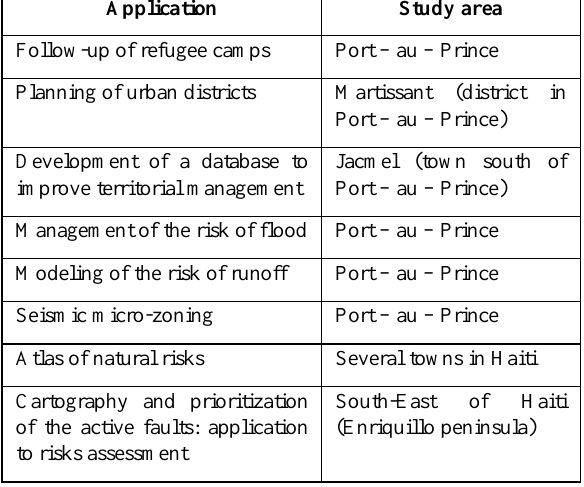
Table 1. Some of the applications of the KAL-Haiti database considered so